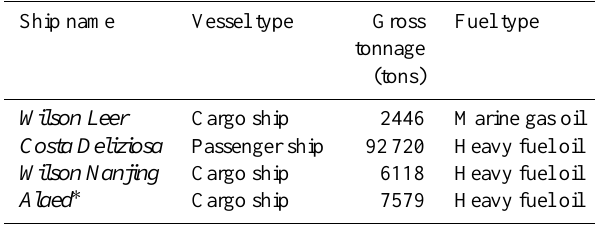
Table 1. Description of the ships sampled during the ACCESS flights on 11 and 12 July